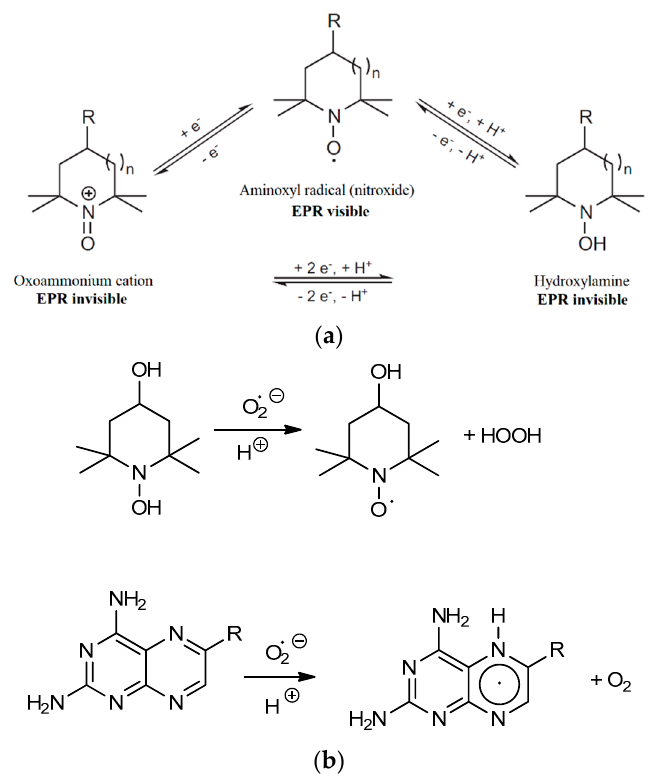
Figure 2. ( a ) (top) Redox species associated with cyclic hydroxylamine spin probe molecules (n = 0 or 1, pyrrolidine or piperidine) [20]. ( b ) (bottom) Proposed redox processes associated with the quenching of superoxide radical by oxidation of hydroxylamine and the reduction of the 1,4-diazine unit of MTX.